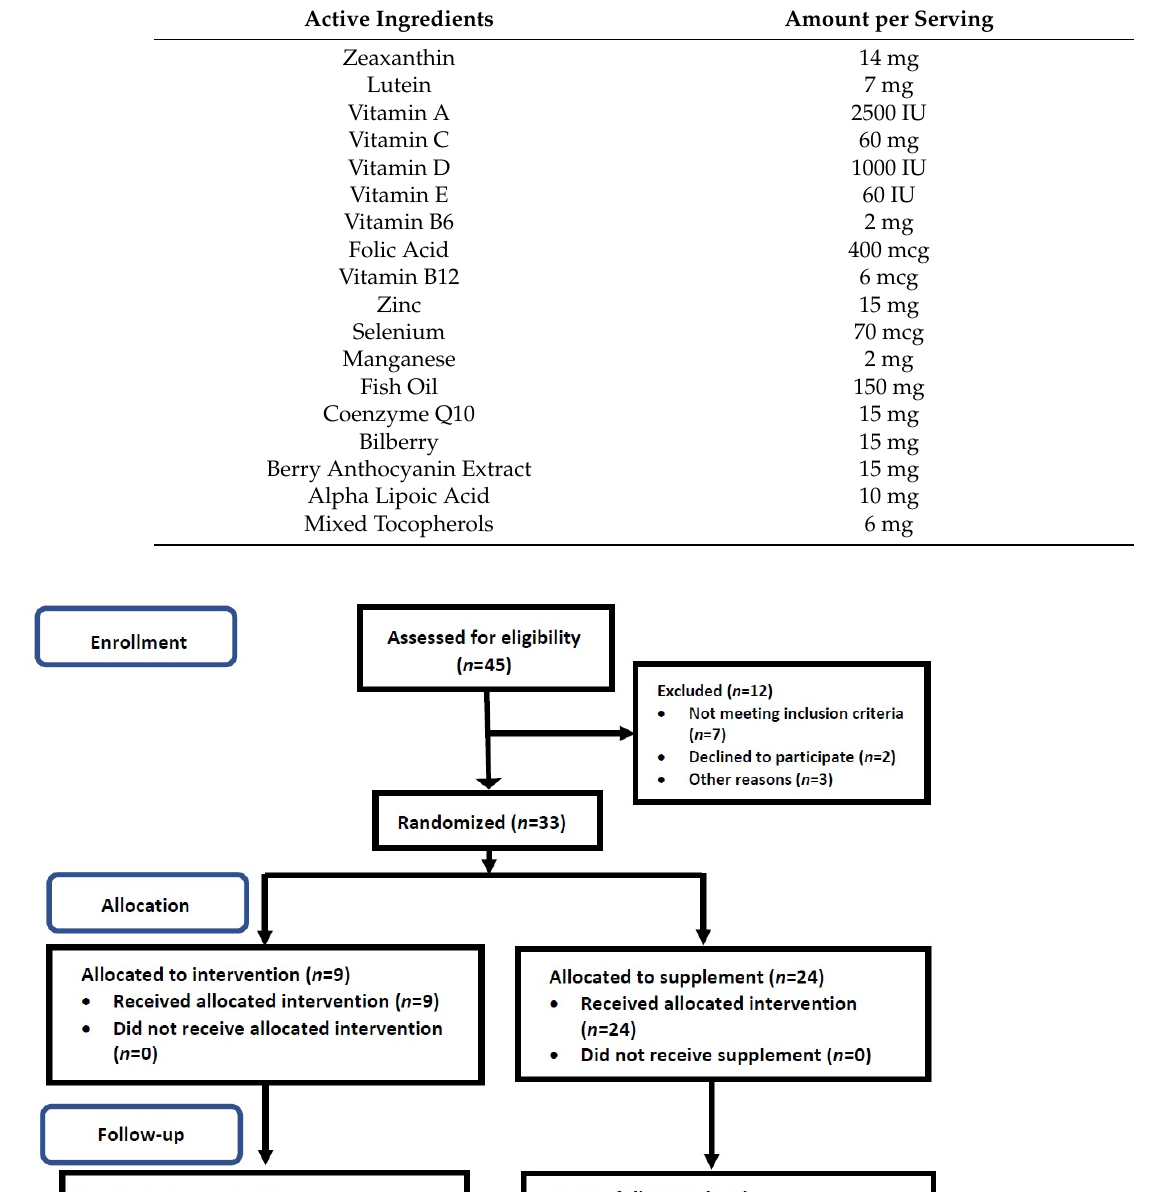
Table A1. Active Components of ScreenShieldPro.